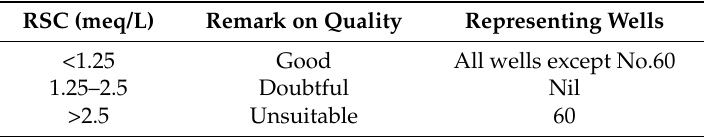
Table 8. Quality of groundwater based on residual sodium carbonate.